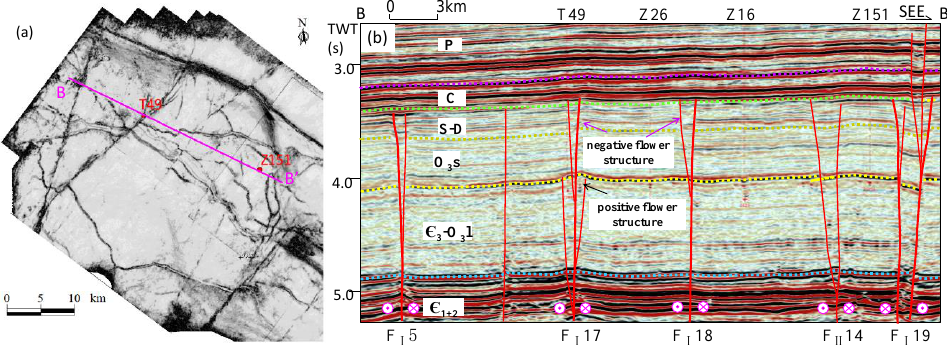
Figure 3. The seismic coherence cube at the top of the Ordovician carbonate ( a ) and the seismic section showing the strike-slip faults across the platform margin ( b ) (see Figure 1a or Figure 3a for the locations) in Block B III .